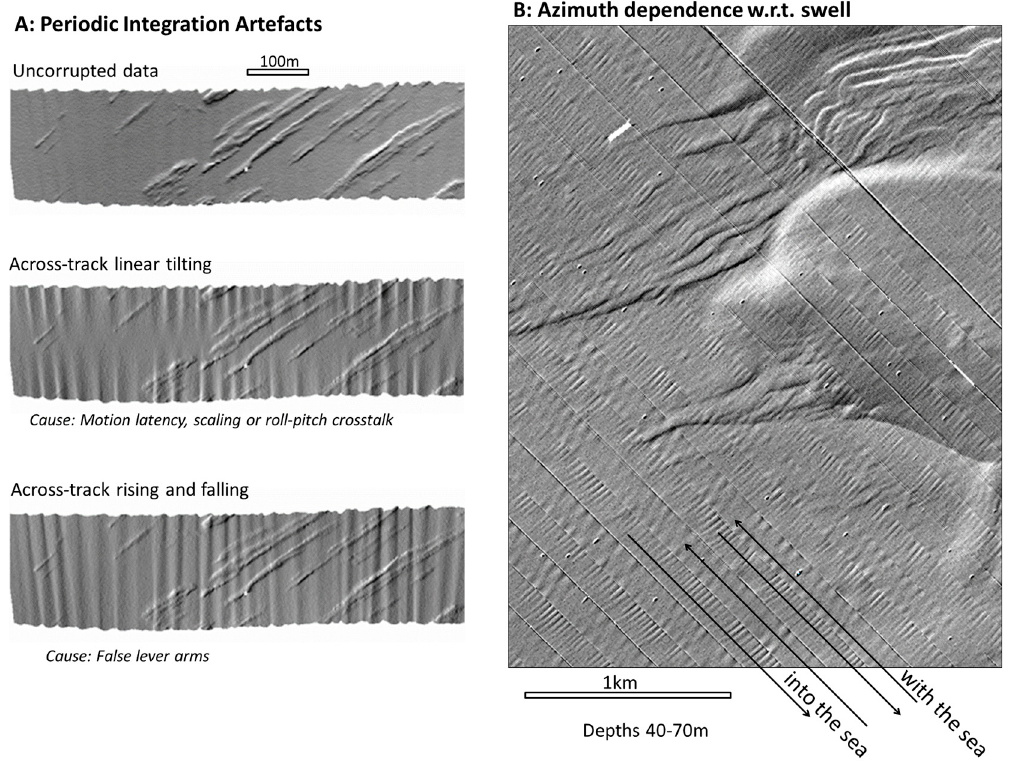
Figure 14. ( A ) The two main characteristics of periodic bathymetric residuals due to imperfect integration; ( B ) the expression of such residuals over real morphology and the Doppler shifting of the roughness as a function of vessel azimuth w.r.t. swell.